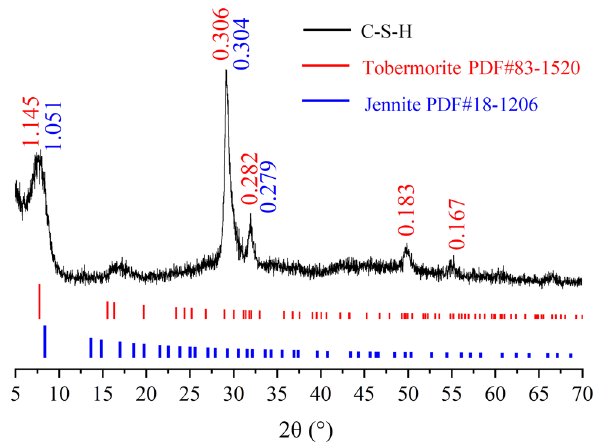
Figure 2: XRD spectra of a representative synthesized C – S – H sample, and the basic d - spacing peak characteristics of tobermorite and jennite.